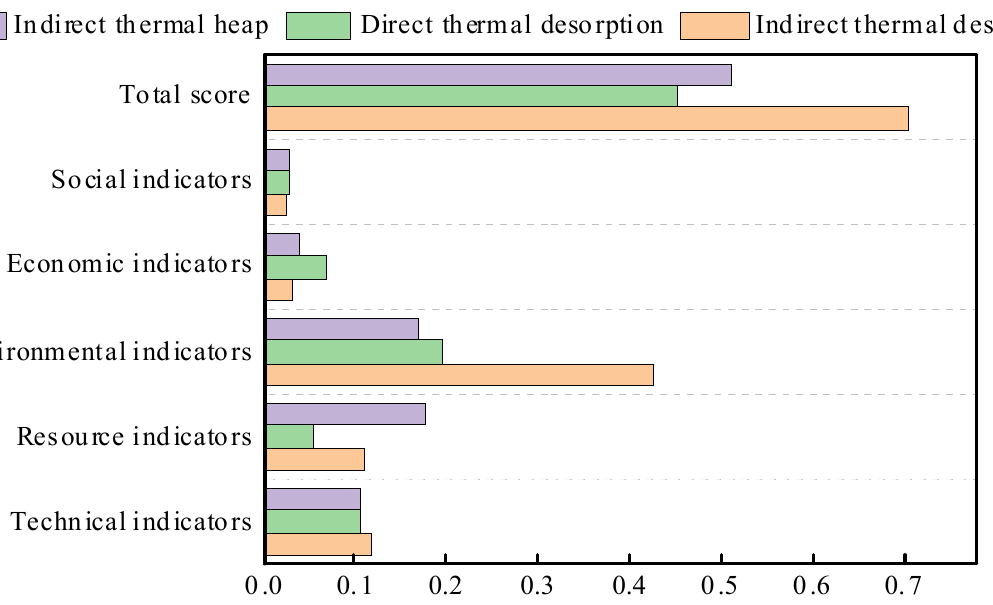
Figure 5. Comparison of primary indicators for the three ex situ thermal desorption processes.